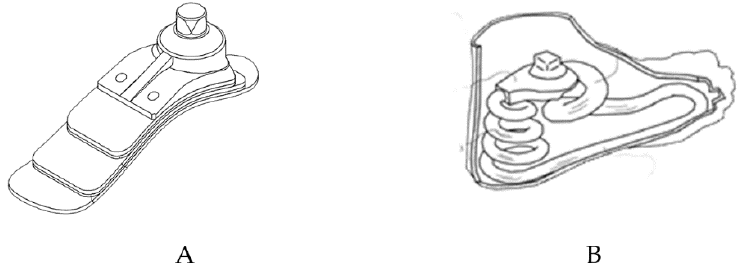
Figure 9. ( A ) Multiple plates prosthesis, ( B ) Single spring prosthesis by Kim Sa Yeop [74].